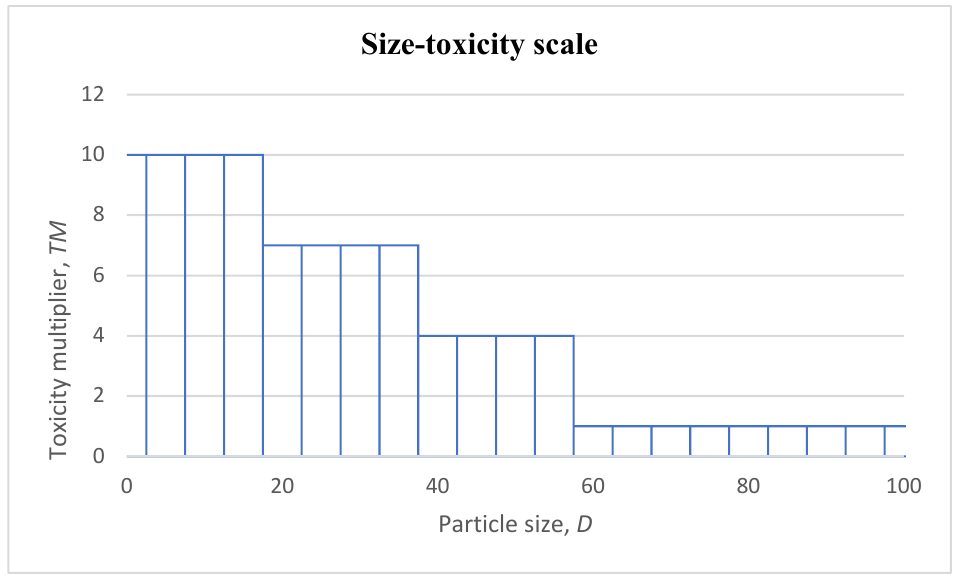
Figure 2. Size–toxicity scale design.